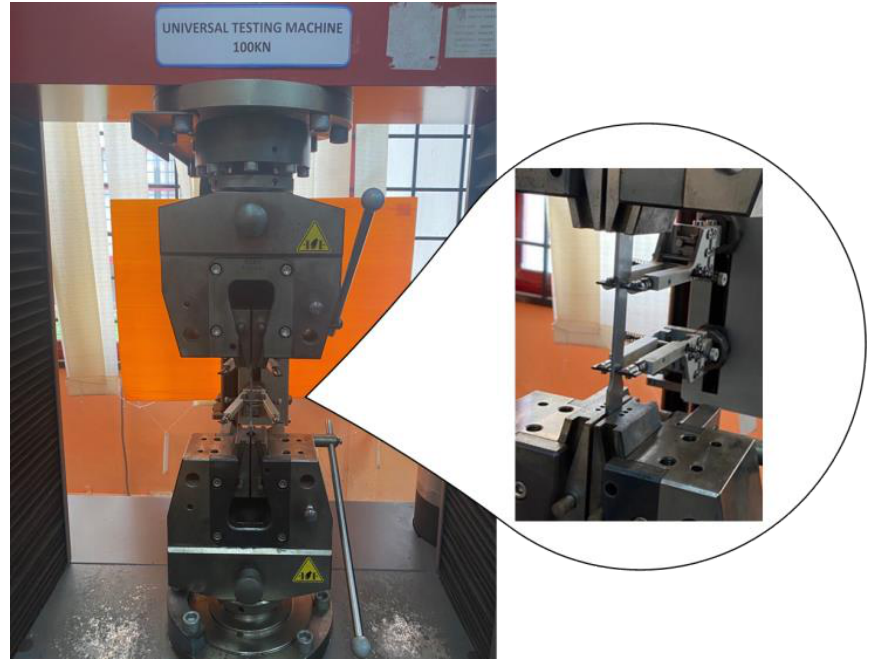
Figure 3. Specimen set-up for tensile test.